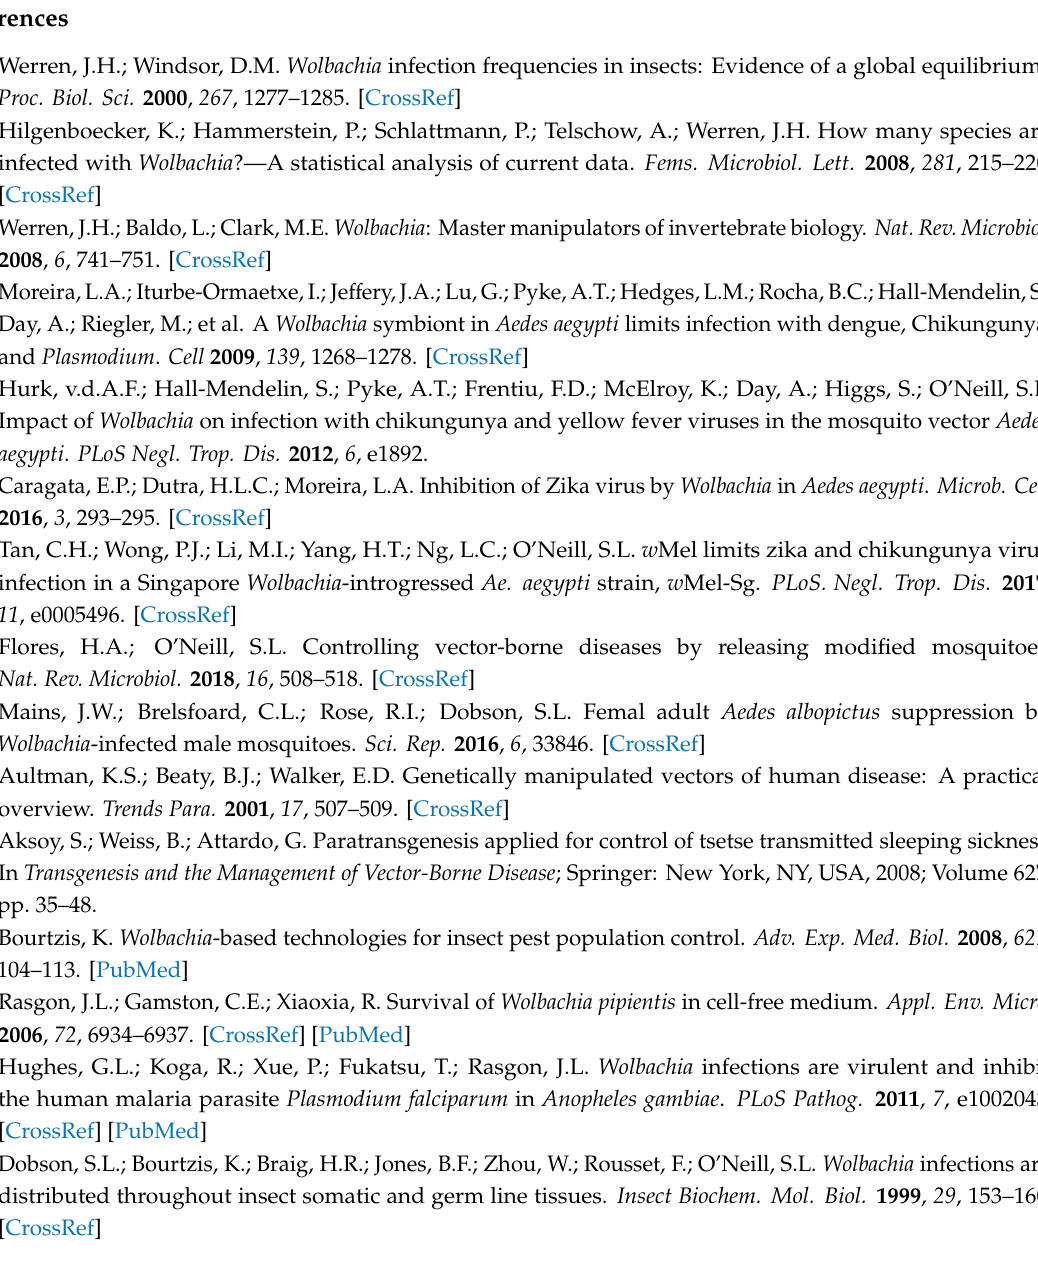
Table S1: Schneider’s media formulation (Sigma–S0146), Table S2: Primer sequences used to assay Wolbachia and other potential bacterial infections in cell cultures and Wolbachia extractions, Table S3: Wolbachia isolate bacterial infections status determined by